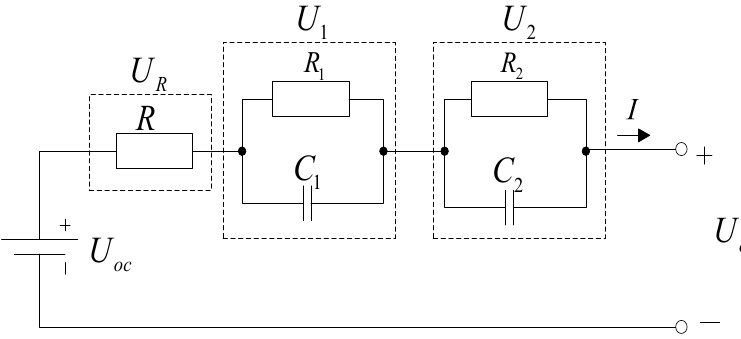
Figure 1. The second-order RC equivalent circuit model.